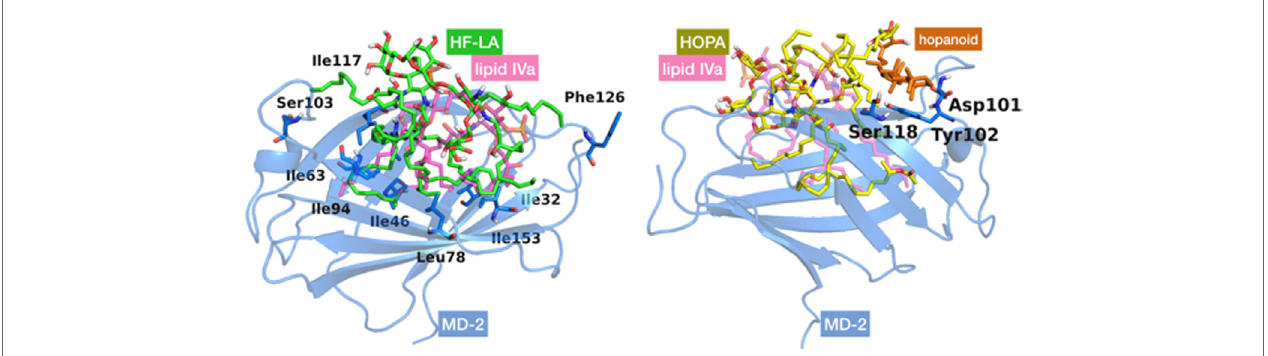
FigUre 5 | Best docked poses for HF-LA, represented in green sticks (on the left), and HOLA, in yellow sticks and the hopanoid residue in orange (on the right), inside myeloid differentiation protein-2 (MD-2) structure. Lipid IV A , added for comparison purposes, is depicted in pink CPK colored semi-transparent sticks. MD-2 is in blue semi-transparent cartoon. Some residues mentioned in the text are in sticks with their corresponding individual